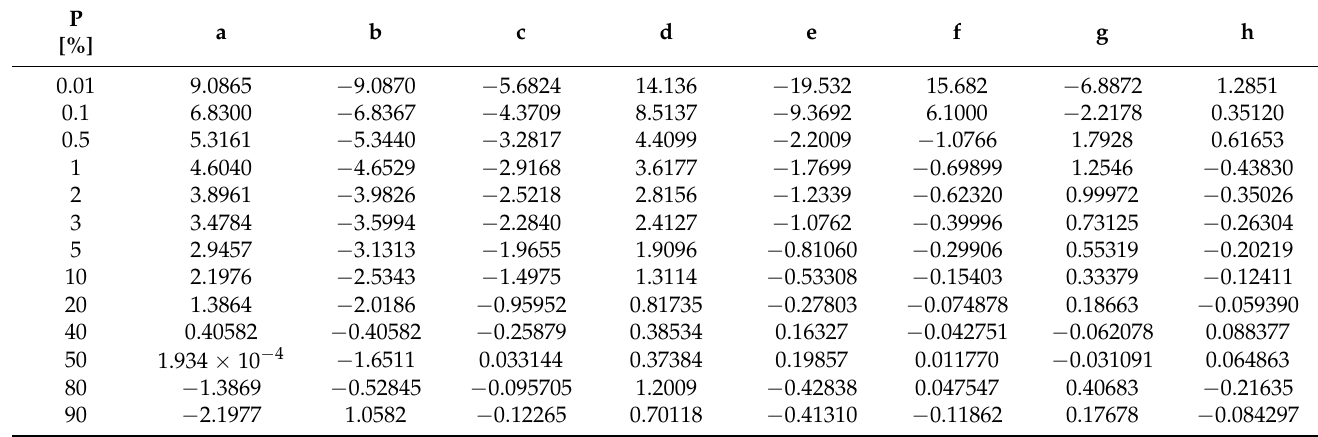
Table A3. The frequency factor for estimation with L-moments.